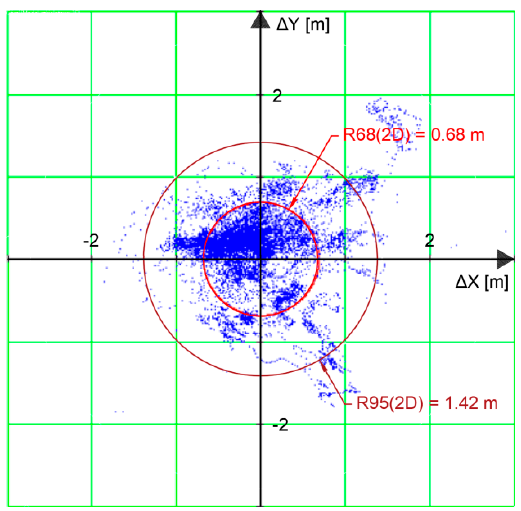
Figure 11. Horizontal position error distribution recorded by the DGPS receiver.